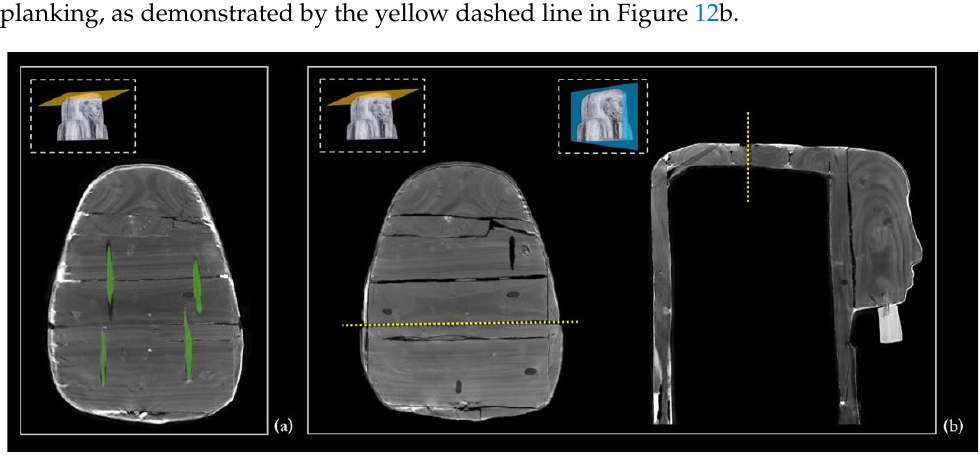
Figure 12. ( a ) The dowels connecting the three planks of the head wall; ( b ) axial and sagittal slices showing the cut of the central plank.